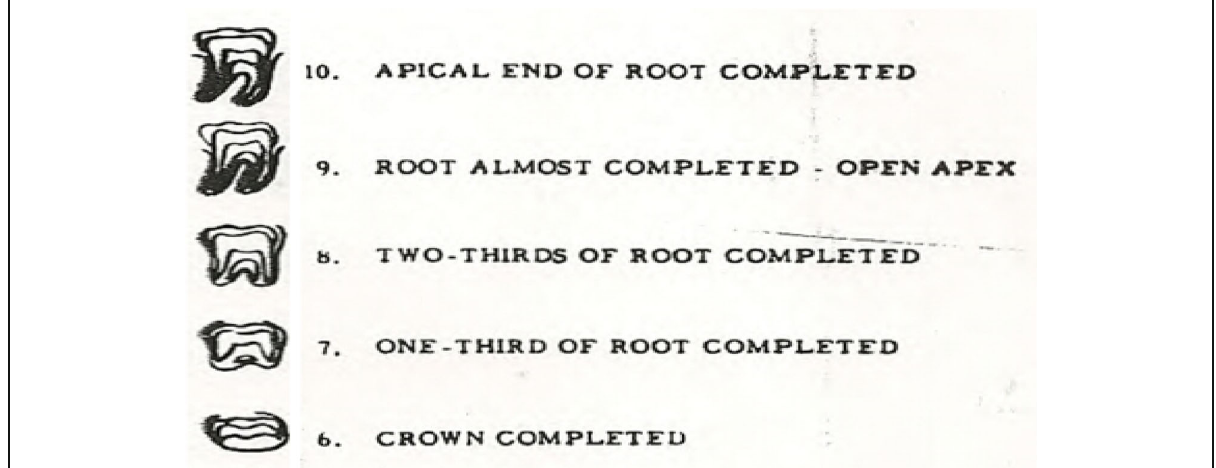
Fig. 1 Nolla ’ s method of staging *only relevant stages were